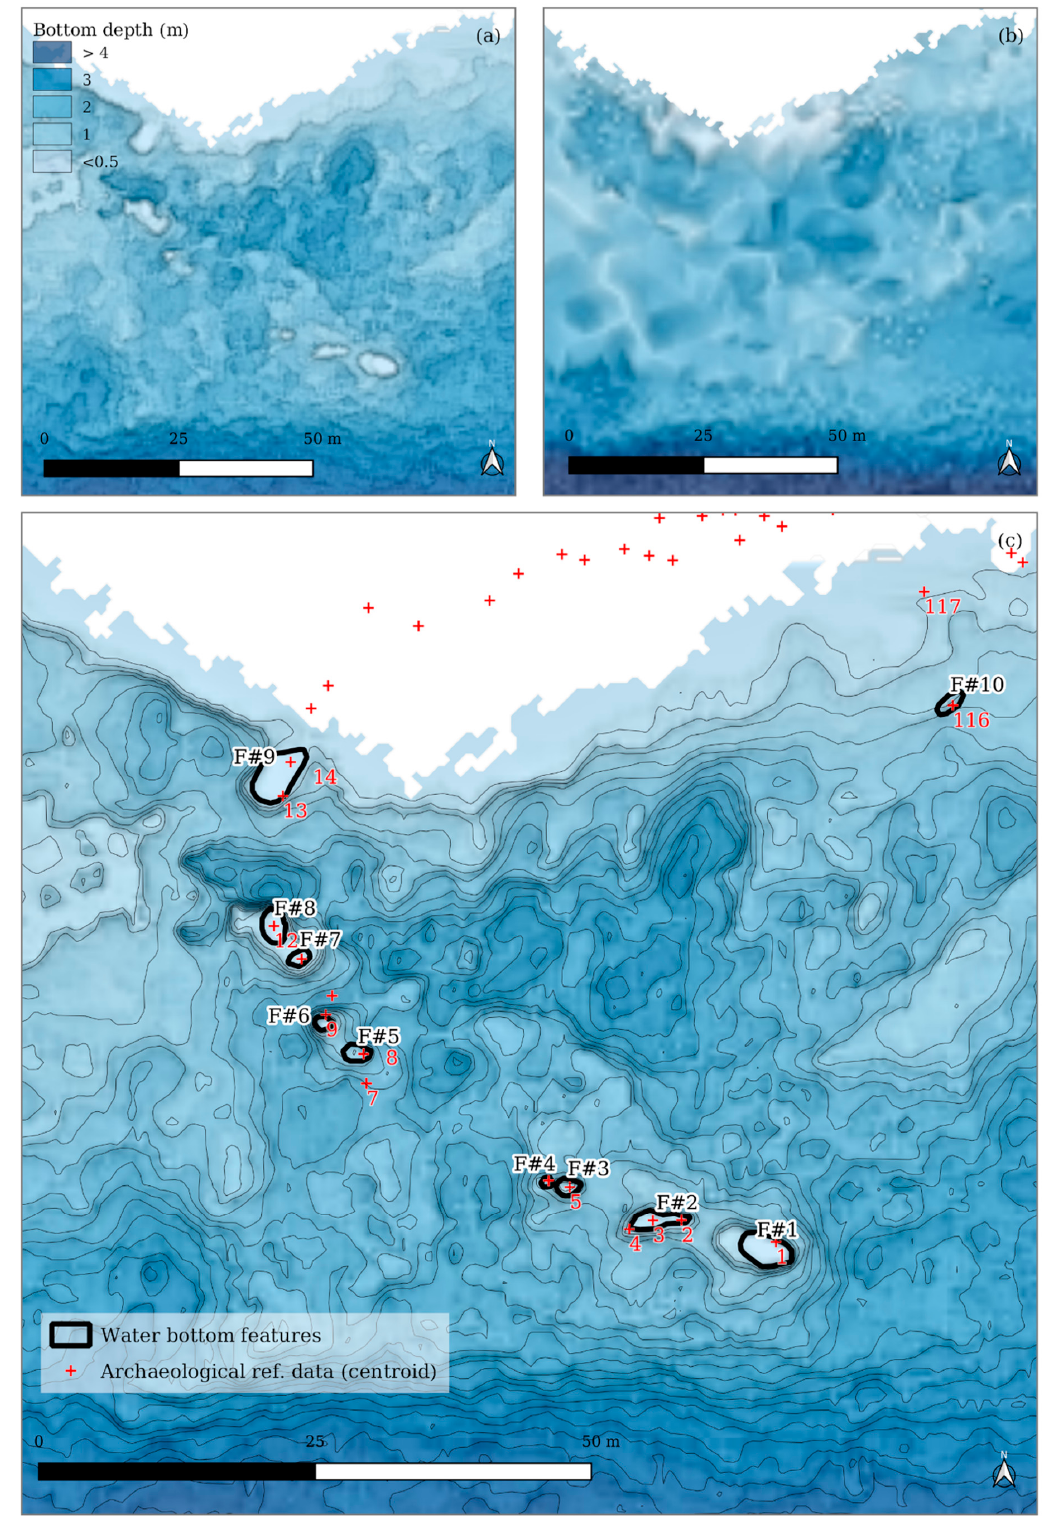
Figure 9. ( a ) Bottom depth estimated from airborne hyperspectral imagery (AHI), ( b ) Litto3D bathymetric data (Shom/IGN) and ( c ) Bottom depth estimated from AHI with extraction of visible water-bottom features (local maxima) from 0.1 m contour lines. Archaeological reference data (stele centroids) are shown in red.